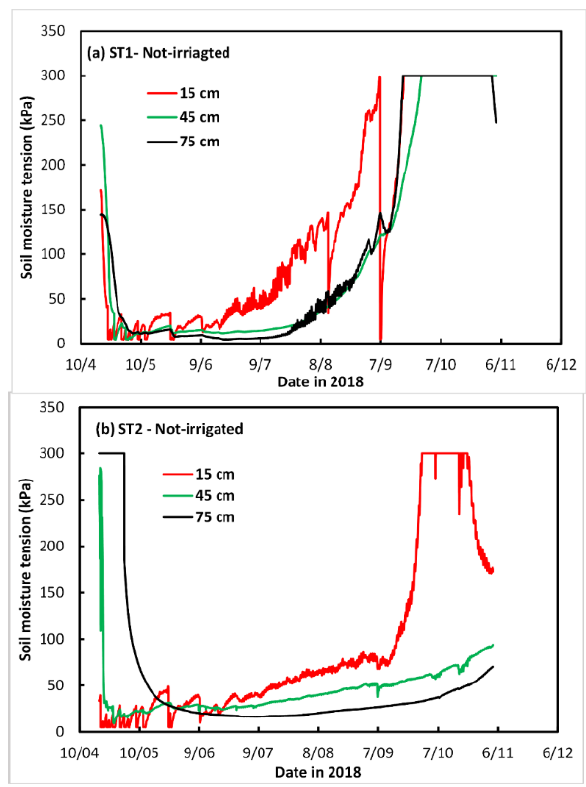
Figure 10. Soil water tension for an early sown and late sown faba bean as monitored using gypsum blocks installed at three depths in the root zone.